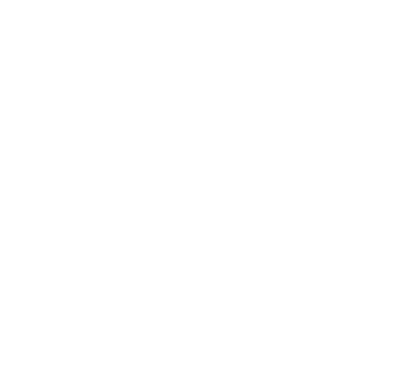
Table 5. Results of the MLR model with 9 selected variables.